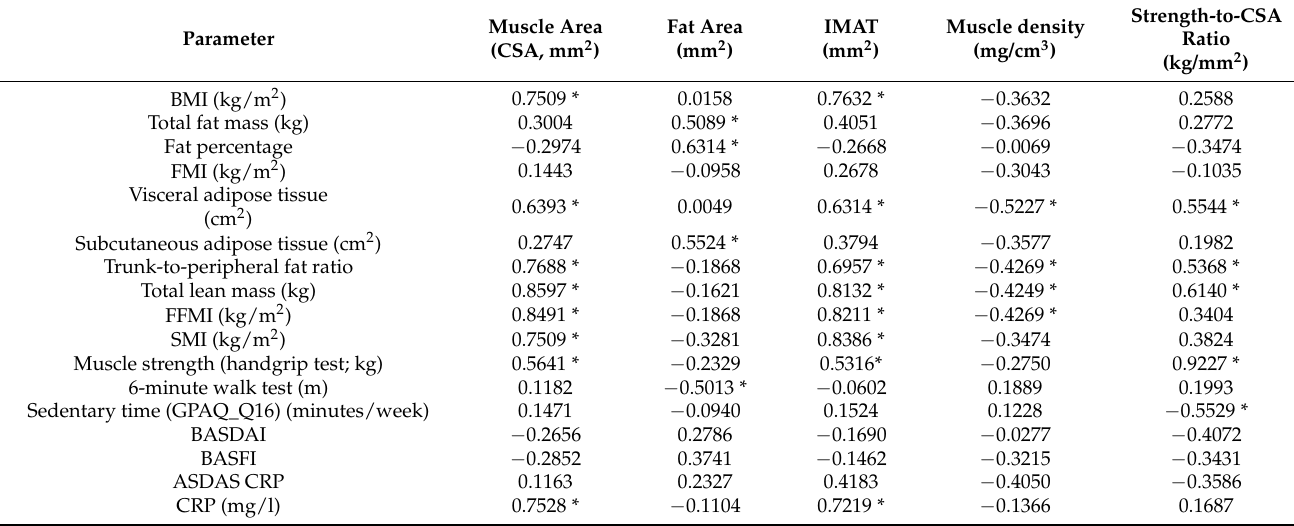
Table 4. Associations in SpA between muscle parameters measured with pQCT, body composition parameters measured with DXA, muscle function, and disease